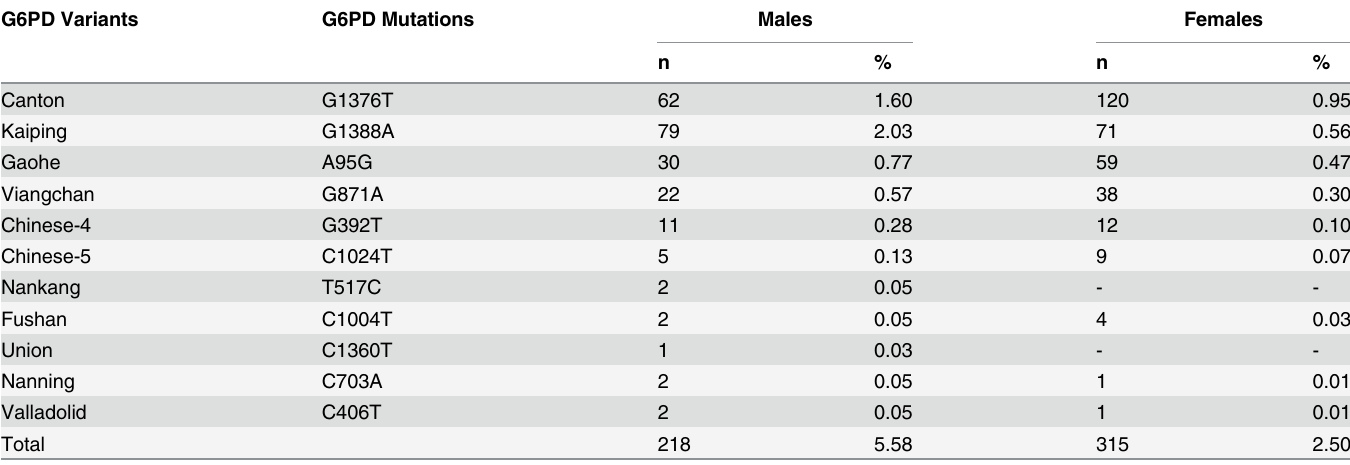
Table 4. The results of screening and genotyping 16 464 samples for G6PD de fi ciency in subsample of “ mainly ” de fi cient subjects in Dongguan District. G6PD